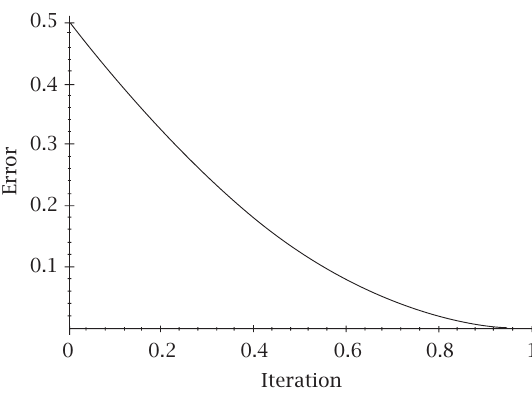
Figure 4.1 . Mean square error of backpropagation